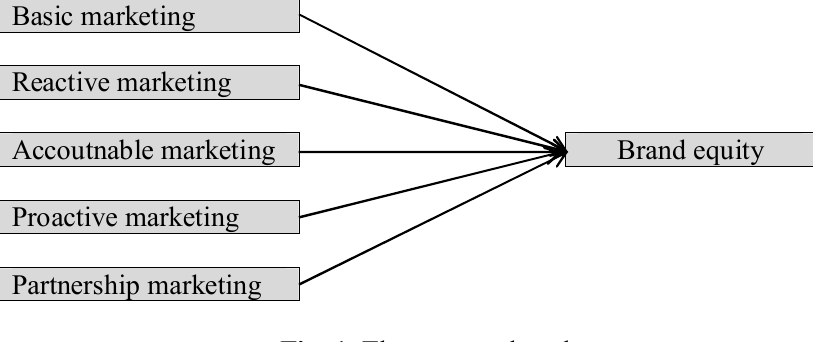
Fig. 1. The proposed study